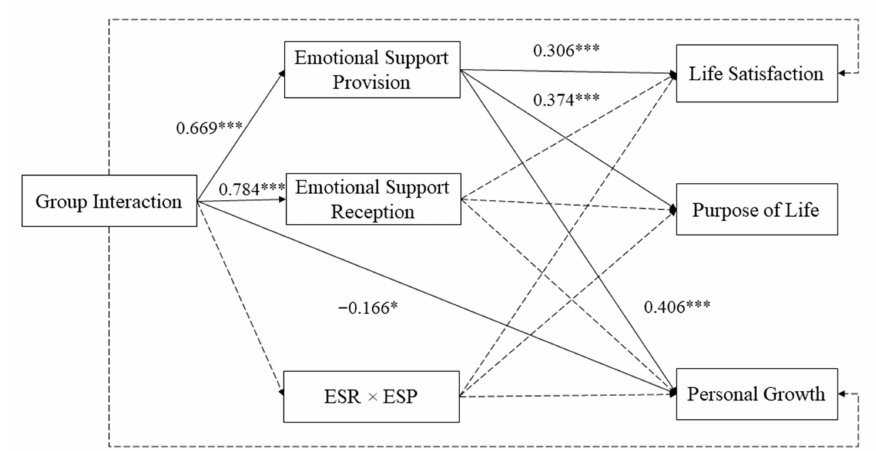
Figure 2. Standardized solutions for the equitable reciprocity model with the control for background and baseline psychological well-being variables. Full lines represent significant relationships. Dotted lines represent non-significant relationships. ESR × ESP = emotional support reception (baseline) ×